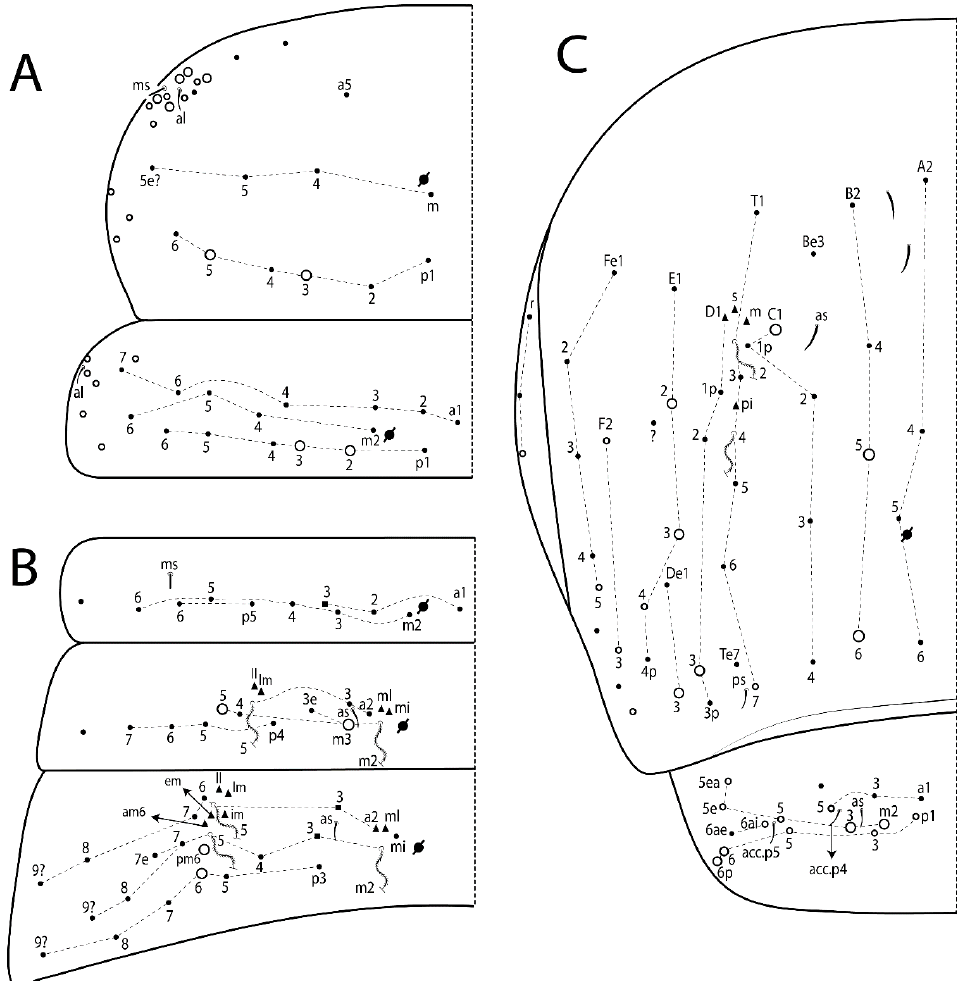
Figure 14. Pseudosinella brumadinhoensis sp. nov.: dorsal chaetotaxy. ( A ) Th II–III; ( B ) Abd I–III; ( C ) Abd IV–V.